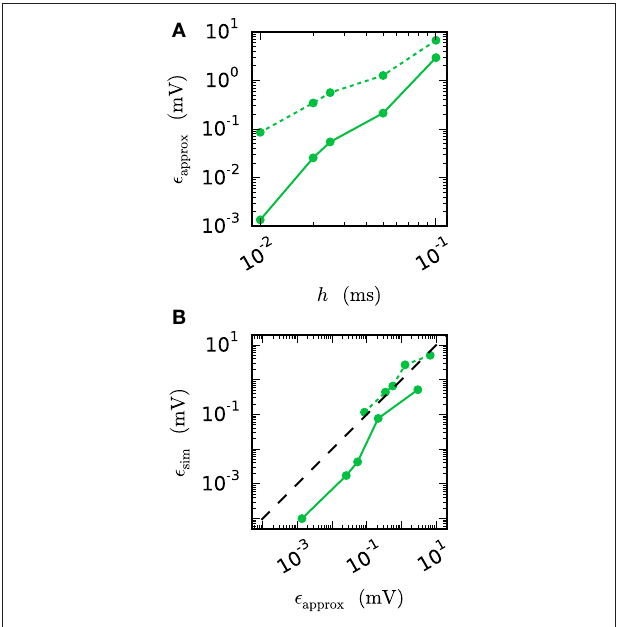
FIGURE 8 | Effect of membrane potential interpolation on network error. (A) RMSE ǫ approx of linear (dashed curves) and cubic (solid curves) interpolation for the action potential shown in Figure 2 as a function of the computation step size h . (B) Integration error for the two-neuron network ( Figure 7 ) as a function of the interpolation error shown in (A) .